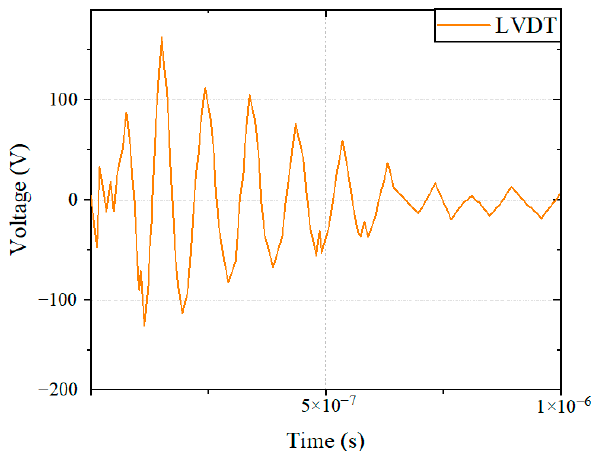
Figure 9. LVDT port monitoring voltage in 10 MHz current injection.